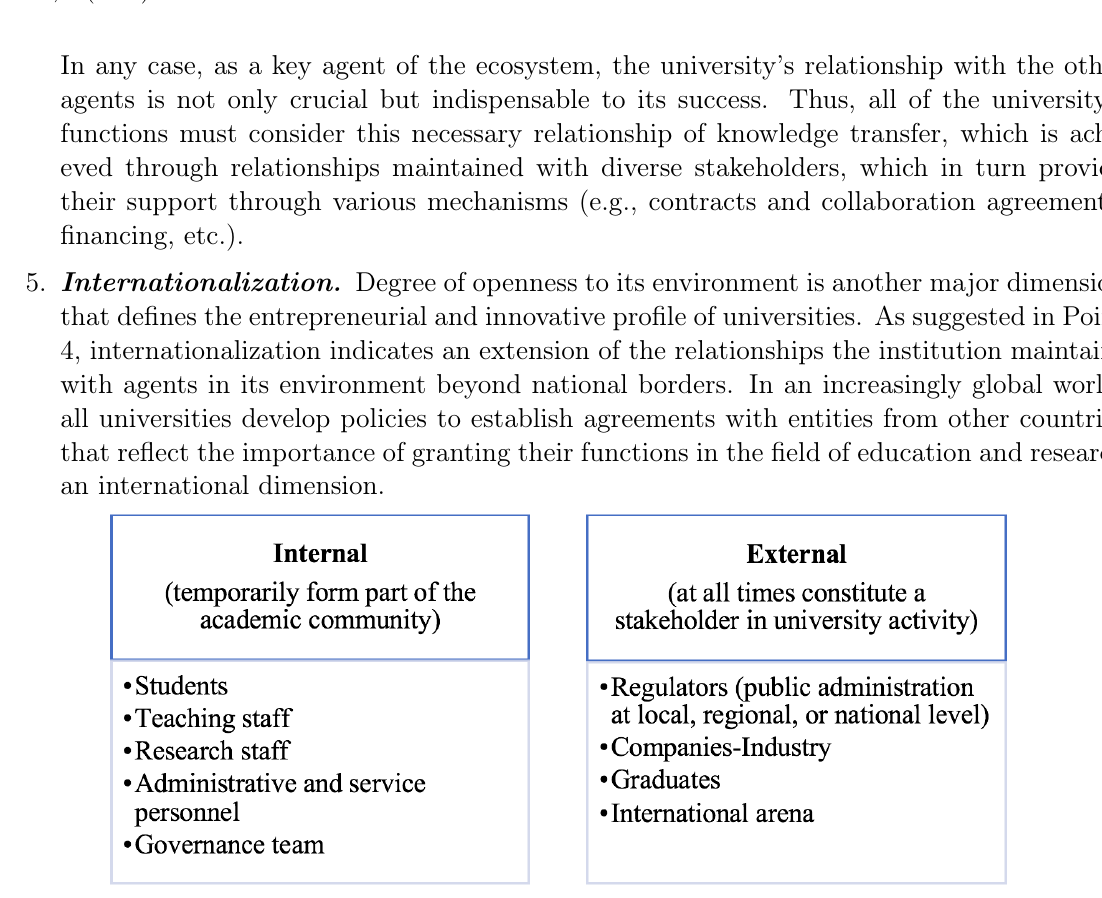
Fig. 2. Stakeholders in the university environment. SOURCE: developed by the